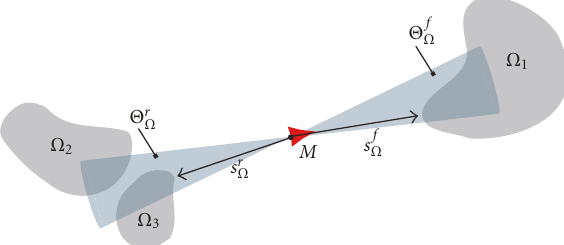
Figure 4: Specification of the obstacle sensor, where Ω denotes an